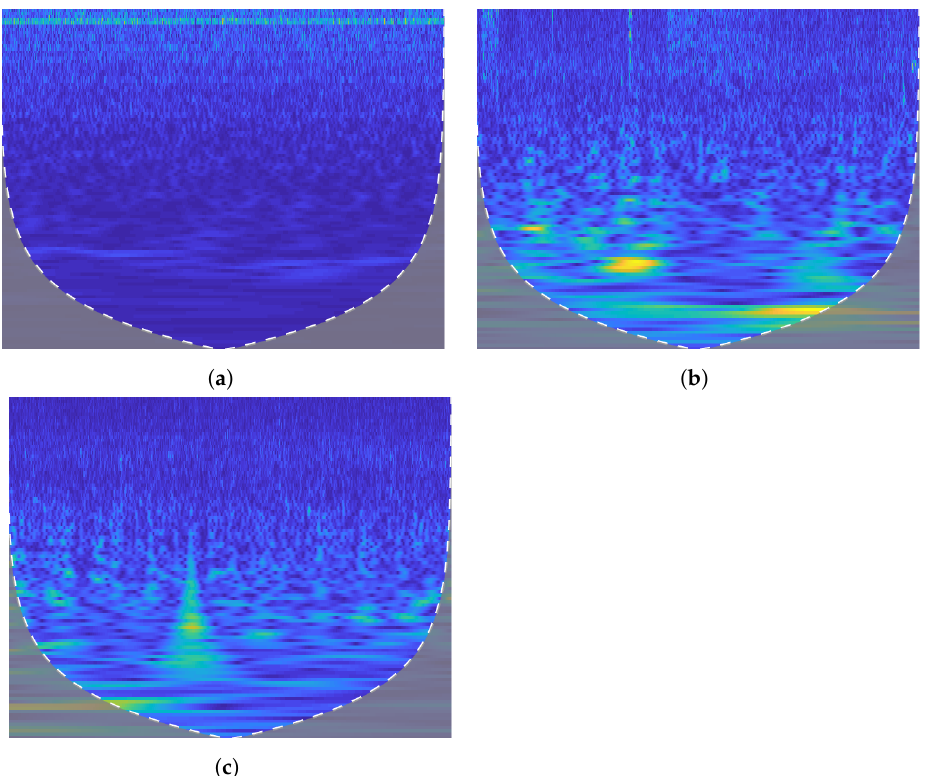
Figure 3. Time frequency distribution for three classes of SEED dataset. ( a ) Neutral. ( b ) Positive. ( c )